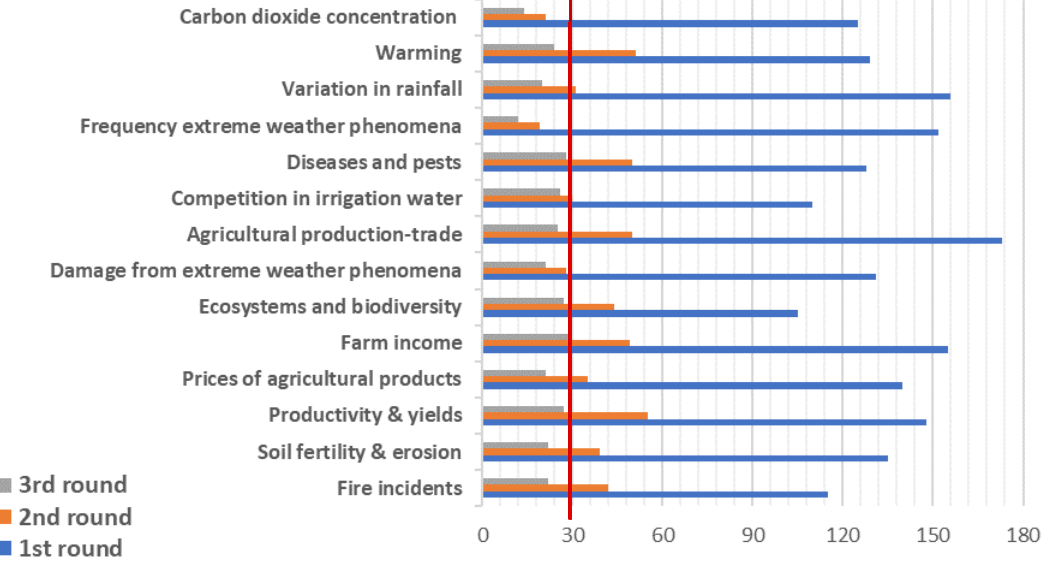
Figure 3. Satisfaction of consensus concept (after 3 rounds).